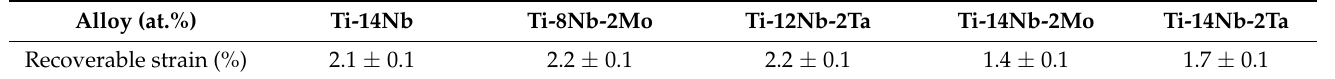
Figure 9. Cyclic compression stress–strain curves of the investigated materials. Table 2. Recoverable strains of the investigated materials.